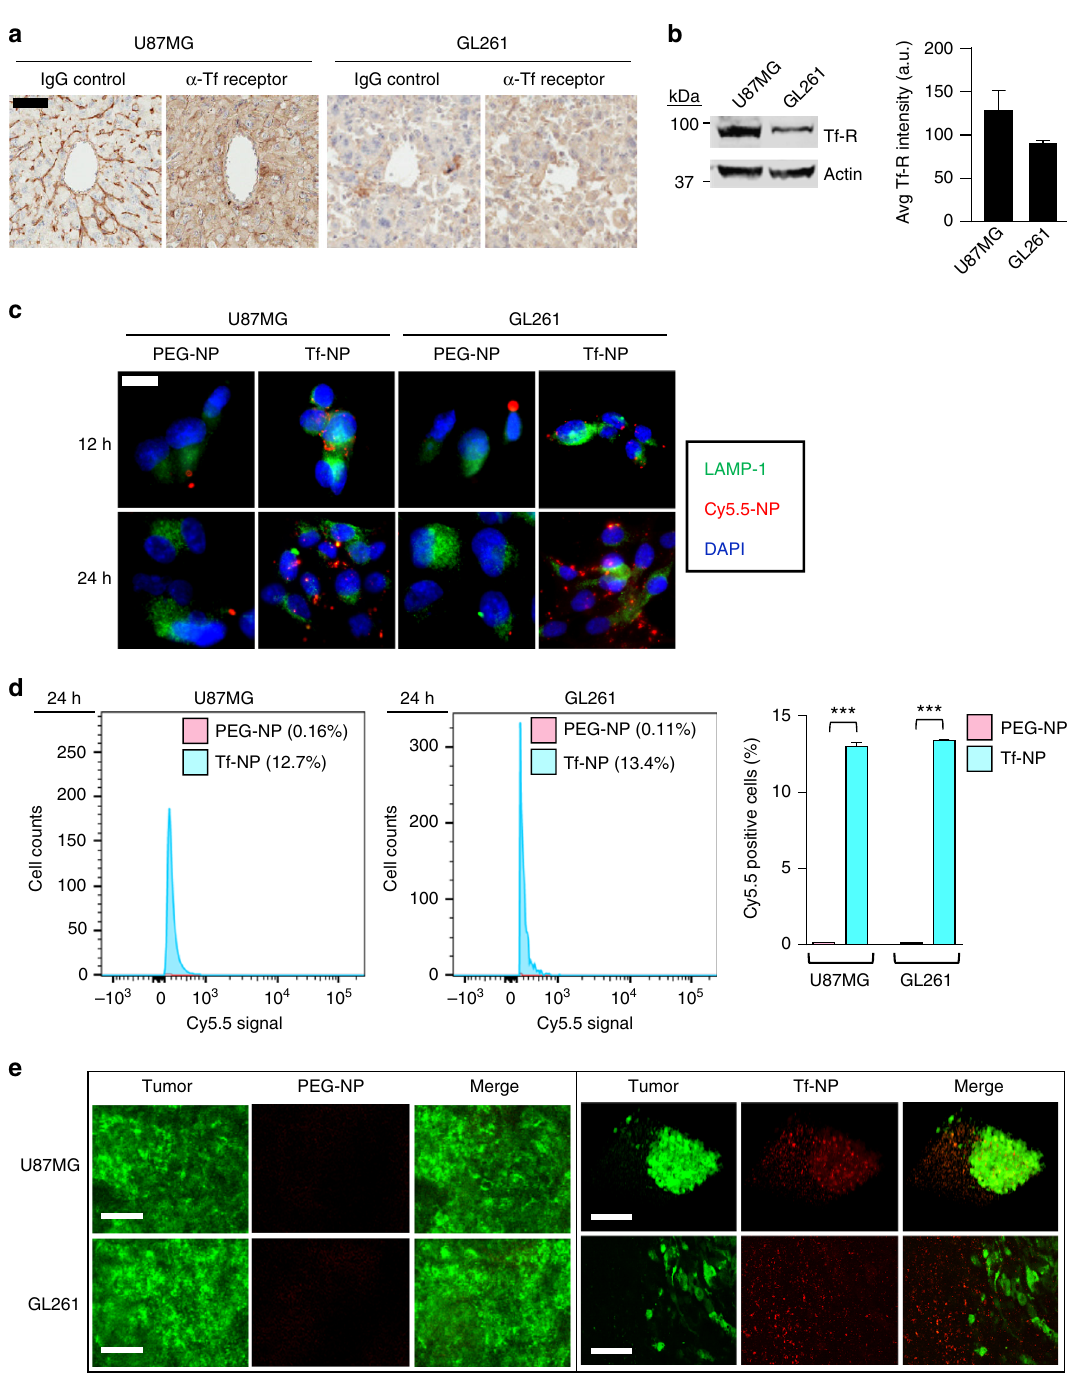
Fig. 2 Transferrin-functionalized liposomes achieve receptor-mediated transcytosis and delivery to intracranial models of GBM. a Immunohistochemistry demonstrates expression of transferrin receptor ( α -Tf receptor) in the endothelium of tumor-associated blood vessels and in tumor tissue of U87MG and GL261 glioma brain tumors. Mouse IgG served as a negative control for non-speci fi c antibody staining (IgG control). Scale bar = 20 μ m. b Representative western blot and quanti fi cation shows ~1.4-fold increased expression of transferrin receptor in U87MG compared to GL261 cells. Data presented as mean ± SEM of three separate experiments. c Immuno fl uorescence staining demonstrates time-dependent intracellular uptake of Tf-NPs but not PEG 2K -Cy5.5 (PEG-NP) liposomes in U87MG and GL261 cells in vitro. Tf-NPs co-localize to late endosomal/lysosomal compartments (LAMP-1). Nuclei were visualized using DAPI counterstain (DAPI). Scale bar = 10 μ m. d Flow cytometry plots and quanti fi cation of cellular PEG-NP or Tf-NP signal in U87MG and GL261 cells. Data presented as mean ± SEM of three separate experiments. Statistical analysis performed using Student ’ s t -test (*** p < 0.001). e Multiphoton images of PEG-NP or Tf-NPs (red) at the site of GFP-expressing U87MG and GL261 intracranial gliomas (green). Scale bars = 6.25 μ m or 12.5 μ